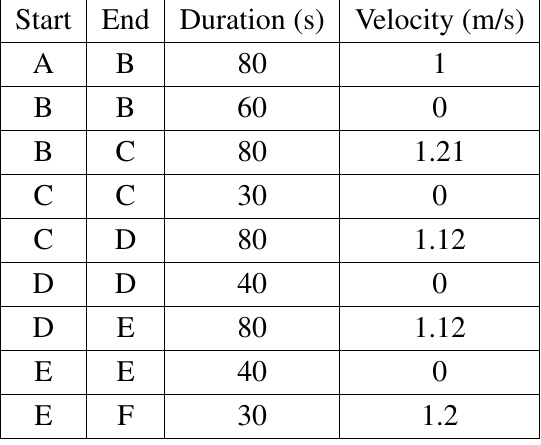
Table 5. The user motion parameters for the ping-pong effect analysis in